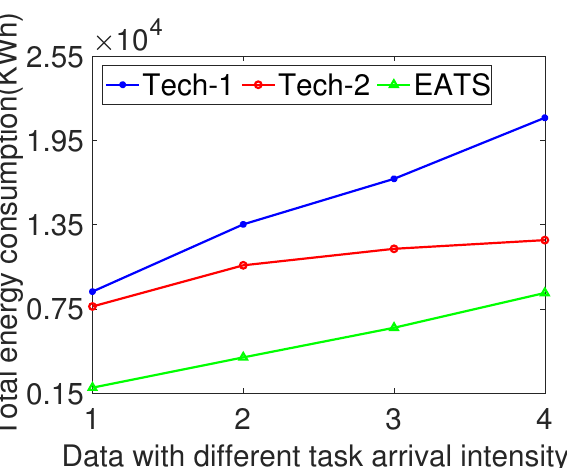
Figure 15. The comparison results of the energy consumption with one module and various